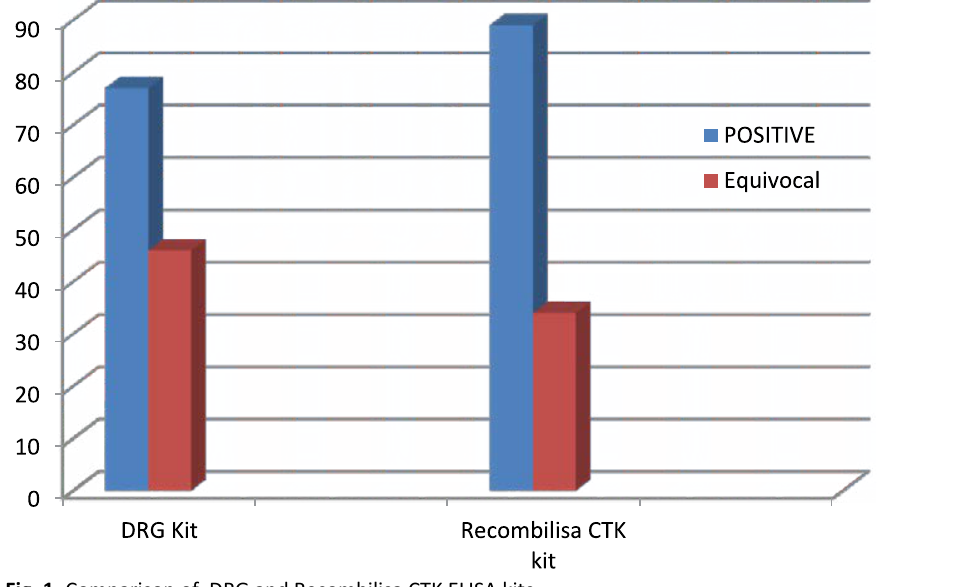
Fig. 1. Comparison of DRG and Recombilisa CTK ELISA